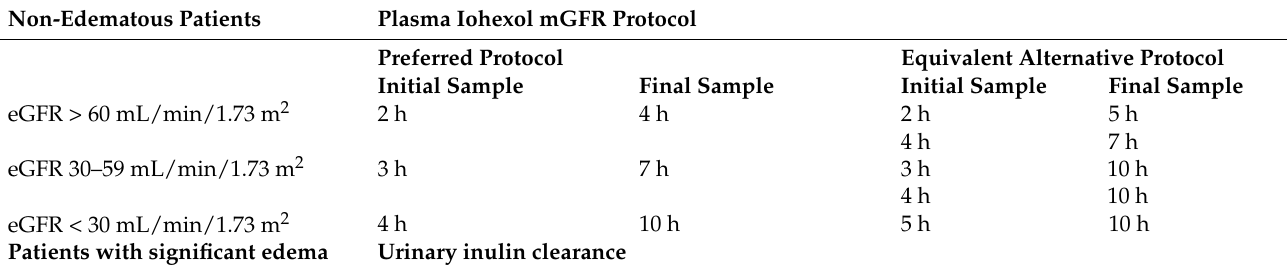
Table 1. Proposed mGFR protocols according to the volume status and the anticipated level of eGFR [49]. Non-Edematous